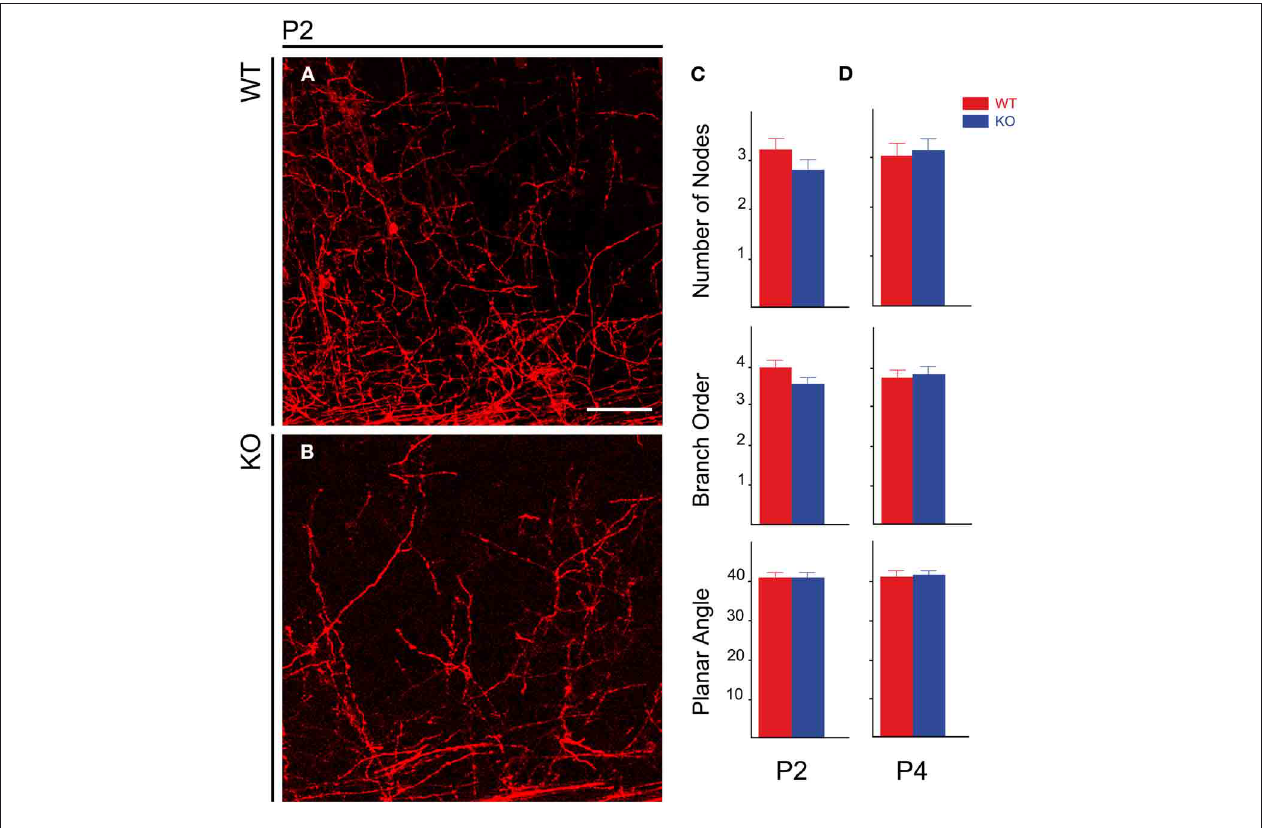
FIGURE 6 | Distribution of TC axons in the lower layers of the developing cerebral cortex in postnatal animals. (A,B) Distribution of TC preterminal axons in the cortical plate of P2 wild type (A) and mutant